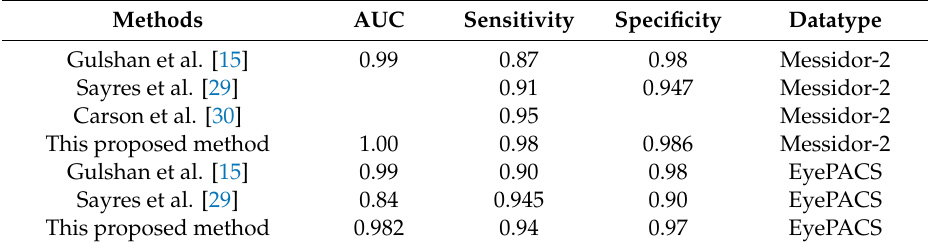
Table 3. Express a clear comparison to other classification-based methods with deep and densely connected